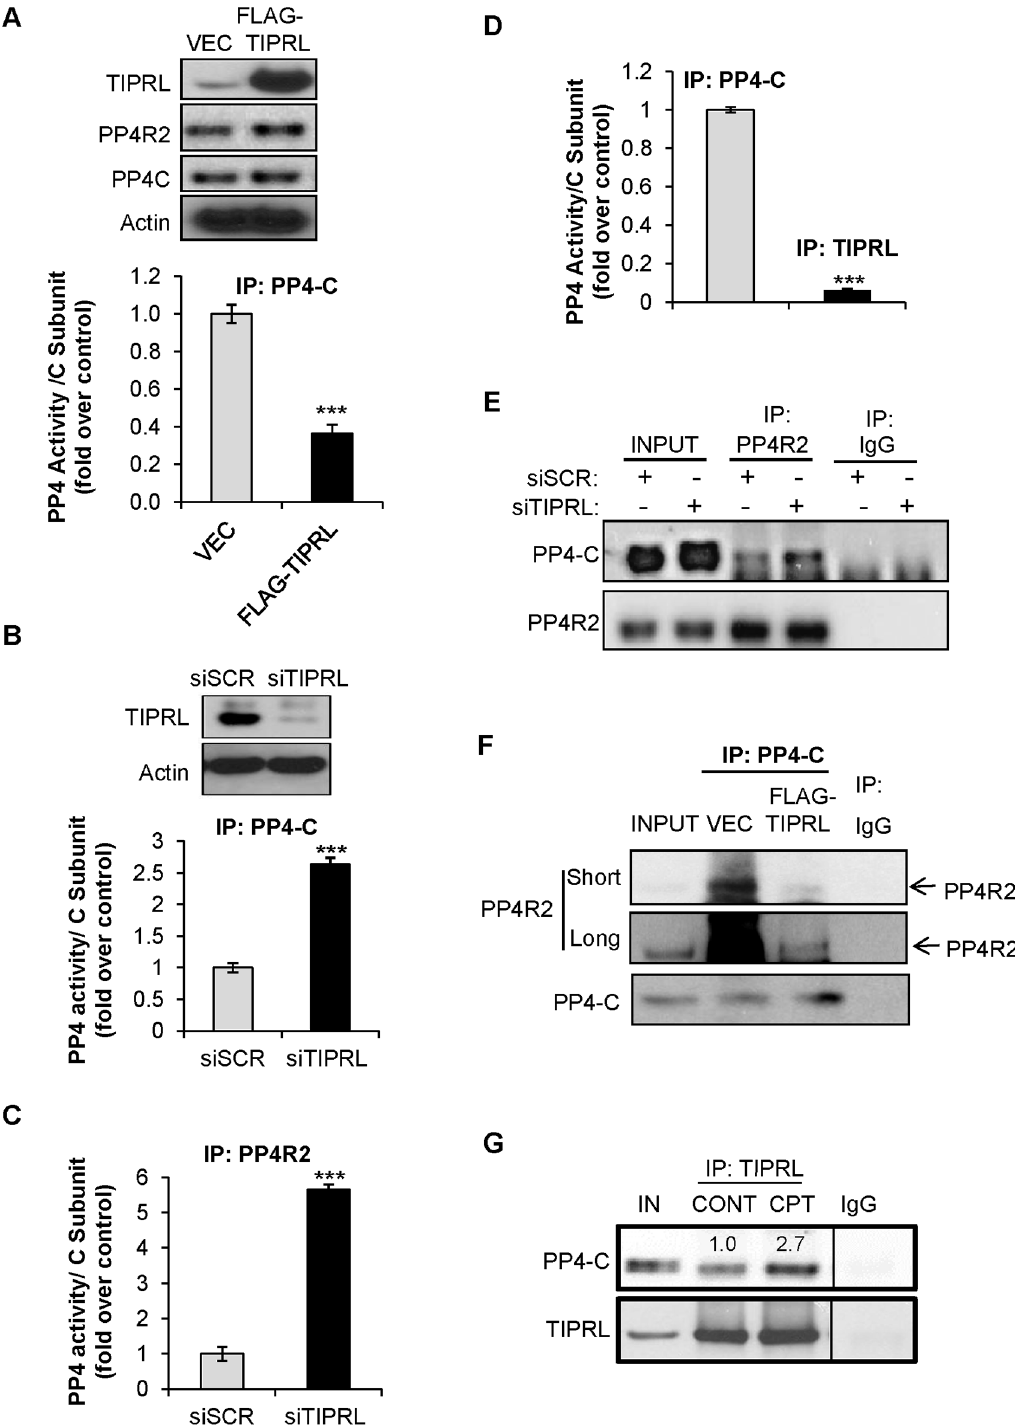
Fig 2. TIPRL inhibits PP4 phosphatase activity and complex assembly. (A) HeLa cells were transiently transfected with LPC FLAG (VEC) or LPC FLAG-TIPRL (FLAG-TIPRL). 24hrs after transfection, cells were lysed and immunoprecipitated with PP4-C antibody, upon which phosphatase activity was measured. Data represent ± standard deviation of the mean of three independent experiments. (B&C) HeLa cells were transfected with a scramble (siSCR) or TIPRL siRNA (siTIPRL). 48hrs after transfection, cell lysates were immunoprecipitated with PP4-C (B) or PP4R2 (C) antibody and phosphatase activity was measured. Data represent ± standard deviation of the mean of three independent experiments. (D) HeLa cells transfected with LPC FLAG-TIPRL (FLAG-TIPRL) were immunoprecipitated with the indicated antibodies and phosphatase activity was measured. (E) HeLa cells were transfected with a